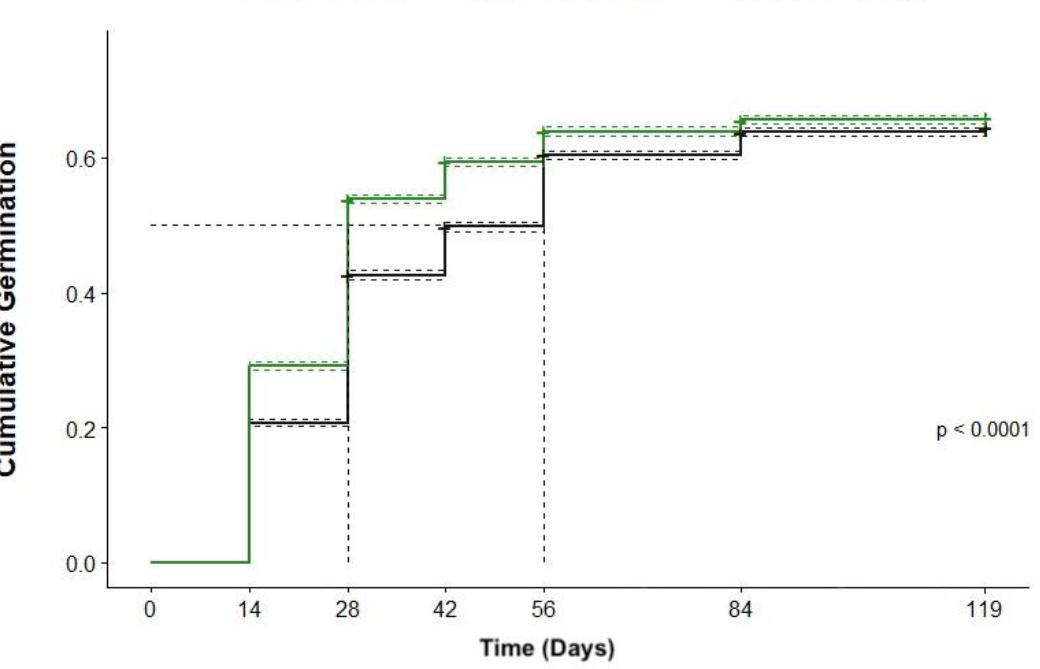
Figure 5. Cumulative germination function for Epidendrum geminiflorum seeds cultured under different photoperiods at 20 °C for 119 days, with 95% confidence intervals.